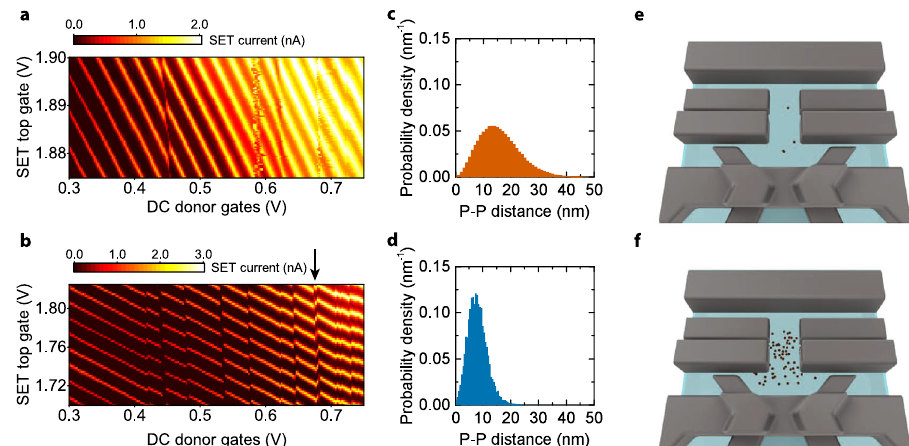
Fig. 3 Comparison of two ion implantation strategies. a , b The current through a single-electron transistor (SET) displays characteristic Coulomb peaks, appearing as bright diagonal lines, as a function of the gate voltages. The presence of a donor coupled to the SET is revealed by discontinuities in the pattern of Coulomb peaks, occurring when the donor changes its charge state. a Charge stability diagram (i.e., SET current vs. SET and donor gates voltages) in a device where P þ molecular ions were implanted at a fl uence corresponding to 5 × 10 10 donors/cm 2 , compared to b a device where P + single 2 ions were implanted with high fl uence, yielding 1.25 × 10 12 donors/cm 2 . The much higher number of observable charge transitions in b is consistent with the higher donor density in the device. An arrow indicates a region where the charge transitions of two different donors cross each other (see also Fig. 4a). molecule implantation at the fl uence of 5 × 10 10 donors/cm 2 . d A much higher probability c Simulated probability density of inter-donor distance for P þ 2 density for small inter-donor distances is obtained for P + implantation at the fl uence 1.25 × 10 12 donors/cm 2 . The device sketches show simulated random placements of donors for the P þ molecular ( e ), and the high- fl uence P + ion ( f ) implantation strategies. Red dots represent P + ions that crossed through 2 the 8 nm thick SiO 2 dielectric layer and stopped in the Si crystal, thus becoming active substitutional